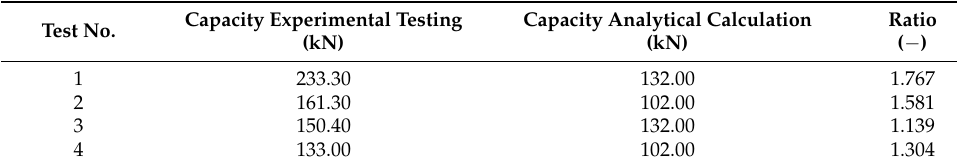
Table 8. Load-bearing capacity of individual frame connections.